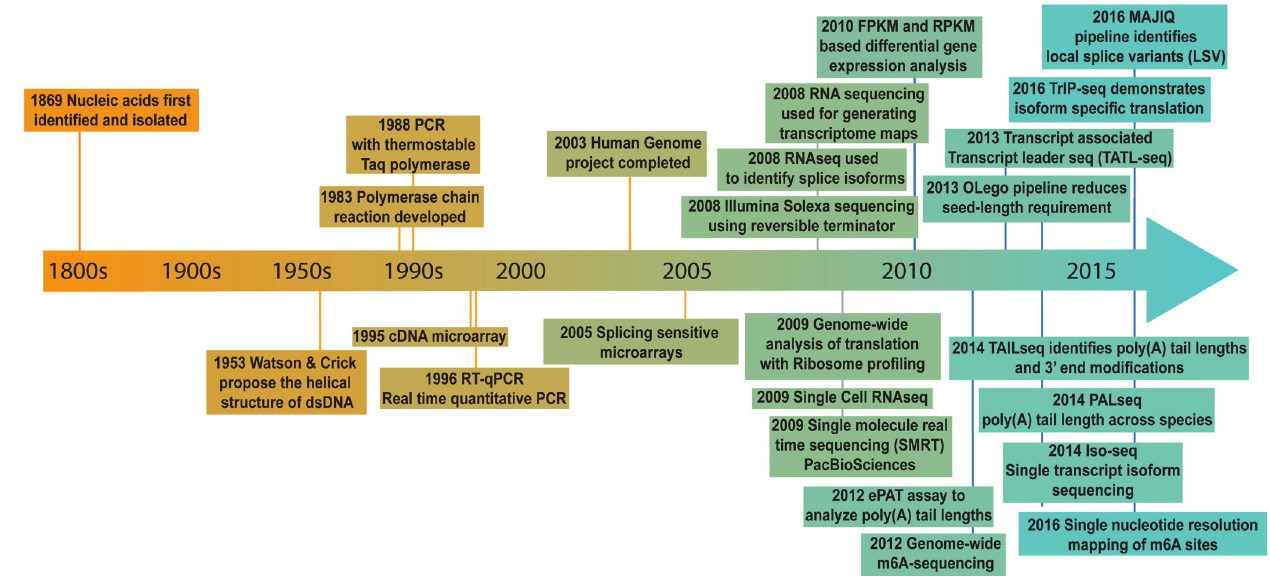
Figure 2. Timeline outlining the recent advances in analyzing RNA variants.